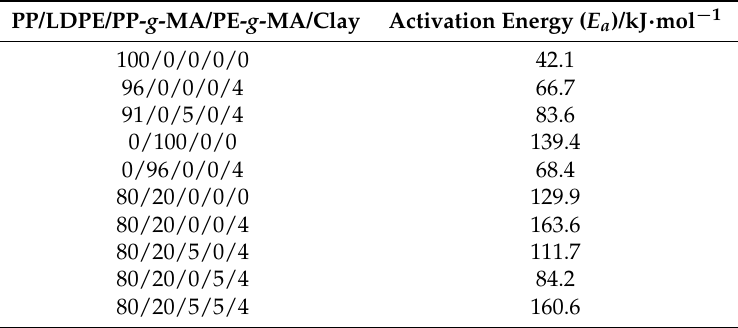
Figure 5. Determination of the activation energy, E a , describing the thermal degradation process of ( a ) PP and the binary composites and ( b ) the neat blend and ternary composites. Table 6. Activation energies based on the Kissinger